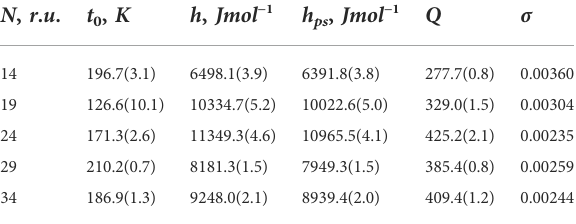
TABLE 2 Results obtained from fi tting for experimental data taken from Wang et al. (2004). Quantities and units same as in Table 1. For all fi ts, the coef fi cient of determination is R 2 =